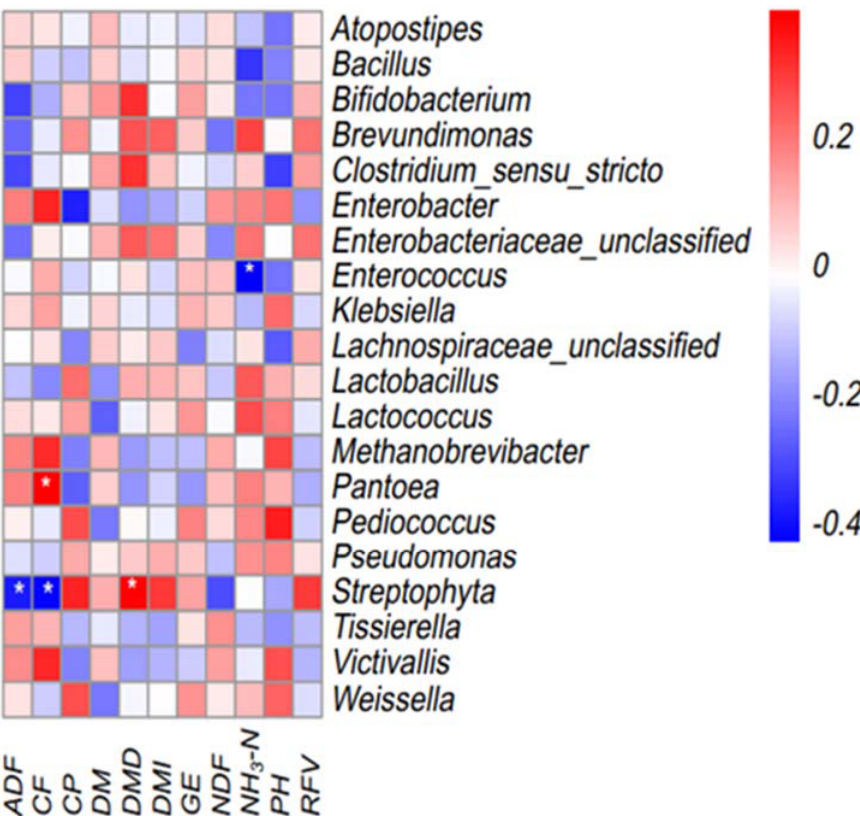
Figure 2. Spearman correlation heatmap between the main genera present in the kudzu silage and its quality. R was presented in different colors, with the right side of the legend showing the color range of the different R values. The value of p ≤ 0.05 is marked with “*”.